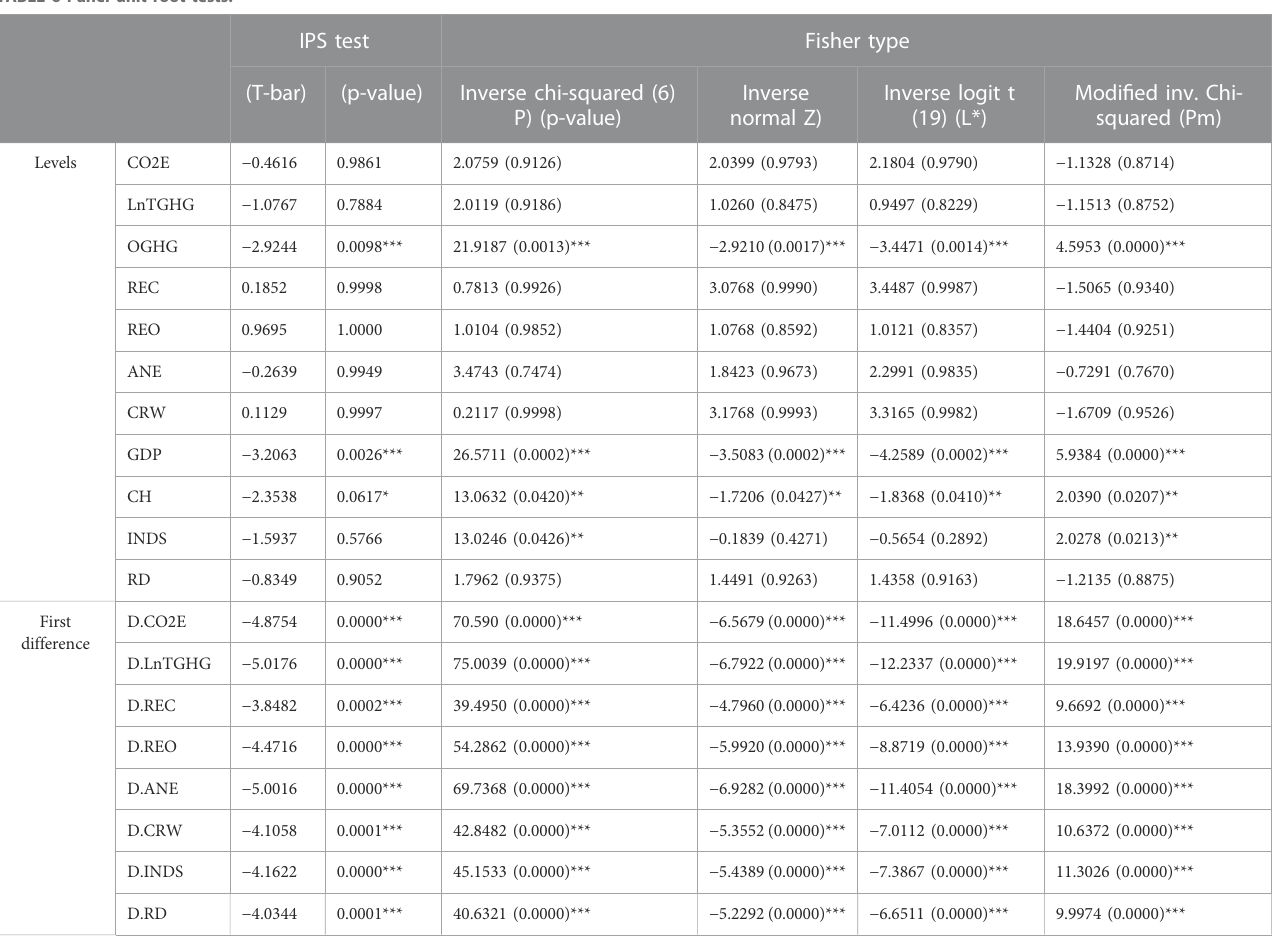
TABLE 6 Panel unit root tests.